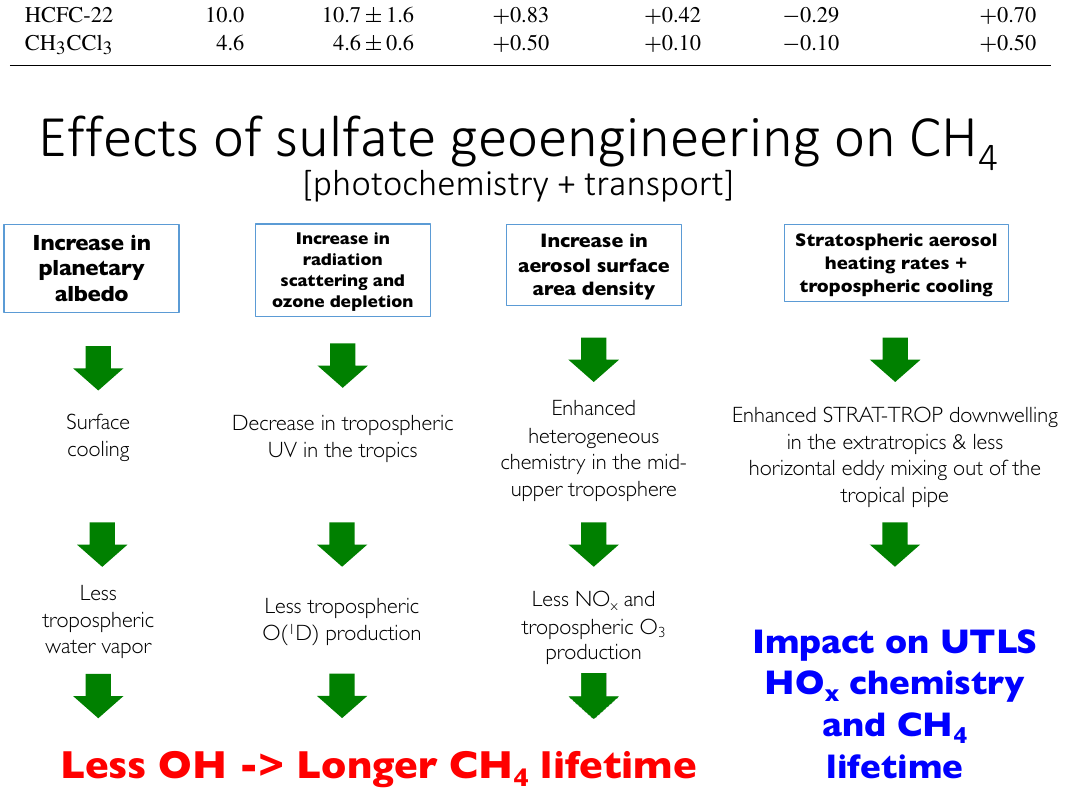
Figure 14. Visual representation of the photochemical and transport effects of sulfate geoengineering on CH 4 , as studied in this paper. Effects connected to perturbed CH 4 emissions due to surface cooling are not shown because they were not explicitly considered in this study. These effects are essentially a decrease in wetland areas connected to reductions in rainfall and halting of permafrost